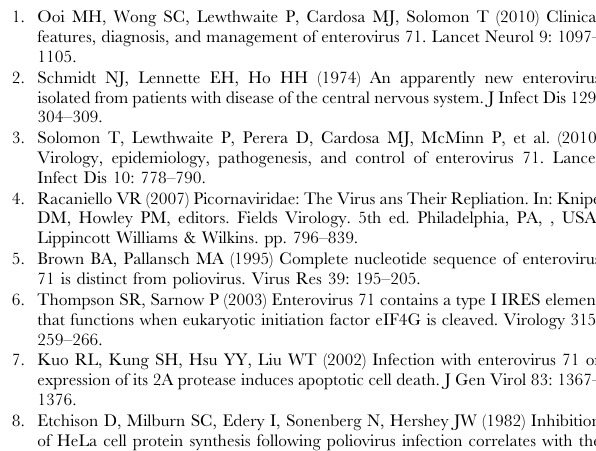
Figure S3 Parallel comparison for MDA5 and RIG-I on IFN- b gene activation upon EV71 infection. HeLa cells were transfected with an empty plasmid or a plasmid expressing the FLAG-MDA5 or FLAG-RIG-I protein for 38 h. The transfected cells were subsequently infected with the MP4 strain of the EV71 virus at 2 MOI. At 9 h post-infection, cell extracts were analyzed by immunoblotting using anti-FLAG M2, anti-MDA5, anti-RIG- I, anti-3C, and anti- b -actin antibodies. (B) Real-time RT-PCR was performed to measure the relative amount of IFN- b mRNA expression. Figure S4 EV71 induces the cleavage of endogenous MDA5 protein. HeLa cells were transfected with 1 m g of EV71 RNA. At 14 h post-transfection, the cells were infected with the MP4 strain of the EV7 virus at 2 MOI. At 3 and 6 h post- infection, cell extracts and total RNA were collected for analyzing. (A) Cell extracts were analyzed by immunoblotting using anti- MDA5, anti-EV71, anti- b -actin, and anti-PARP antibodies. (B) Real-time RT-PCR was performed to measure the relative amount of IFN- b mRNA expression. Figure S5 Overexpressed MDA5, but not RIG-I, is degraded during EV71 infection. (A) HeLa cells were transfected with an empty plasmid or a plasmid expressing the FLAG-MDA5 or FLAG-RIG-I proteins for 24 h. The transfected cells were subsequently infected with the MP4 strain of the EV71 virus at 2 MOI. At 9 h post-infection, cell extracts were analyzed by immunoblotting using anti-FLAG M2, anti-3C, and anti- b - actin antibodies. (B) The extracts from the FLAG-MDA5 transfected cells were also analyzed by immunoblotting using an anti-MDA5 antibody. The asterisk indicates the putative cleavage product of the MDA5 protein. Figure S6 Examining the effect of caspase-dependent MDA5 cleavage on IFN- b mRNA production upon EV71 infection. HeLa cells were transfected with a plasmid expressing the FLAG-MDA5 for 22 h The transfected cells were subsequent- ly infected with EV71/MP4 strain in presence or absence of a broad spectrum caspase inhibitor, Q-VD-OPH, at final concen- tration of 20 nM. Cell extracts and total RNA were collected at